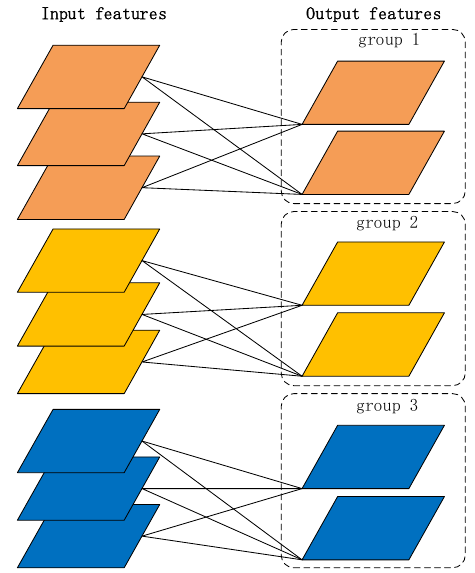
Figure 5. Group convolution.